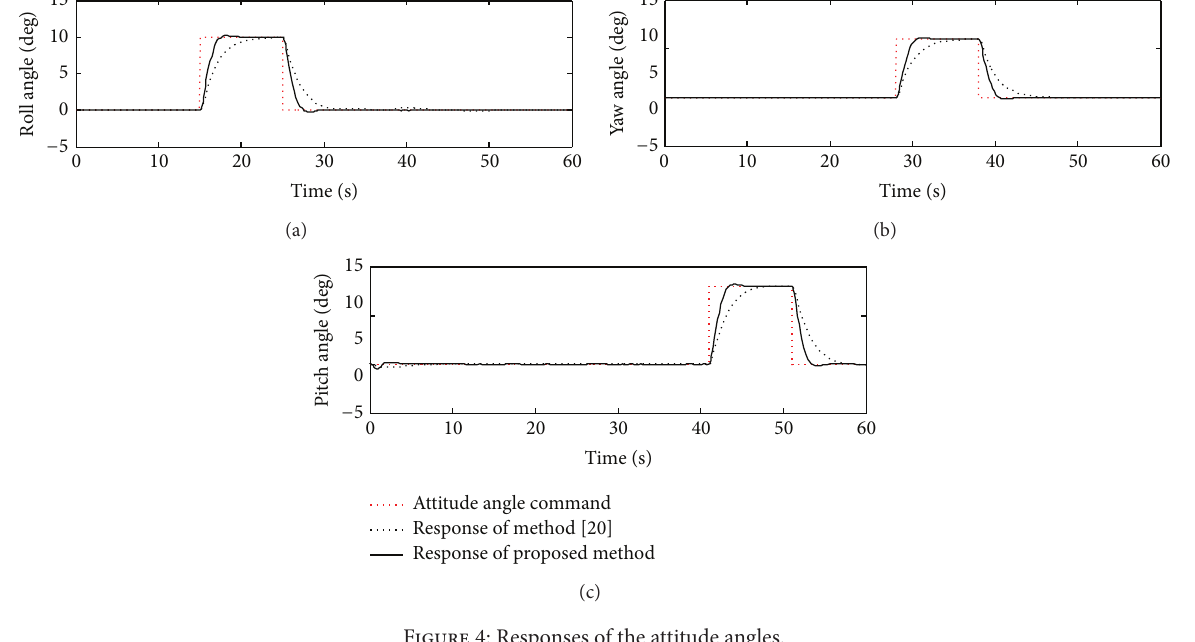
Figure 4: Responses of the attitude angles.